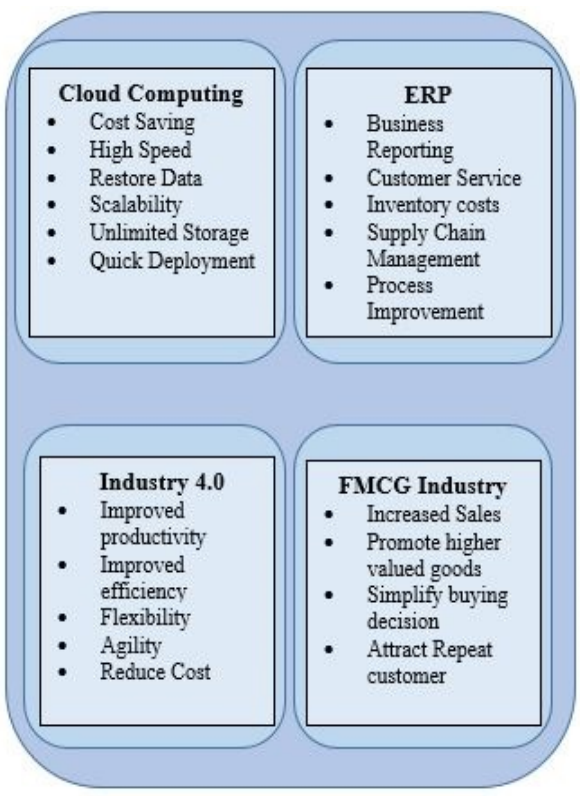
Figure 4. Benefits of combining cloud computing, ERP, Industry 4.0 and FMCG Industry.